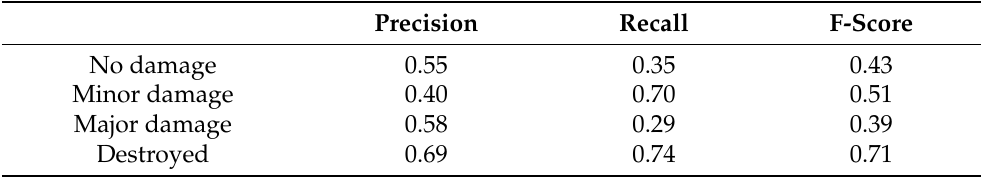
Table 7. Performance metrics for Model 2 (undersampling